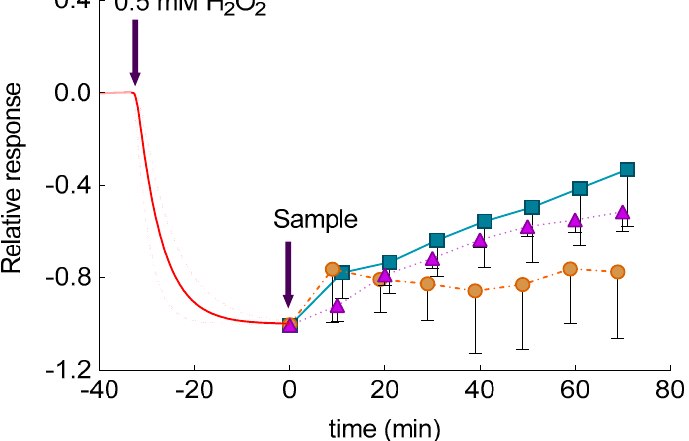
Figure 7. Relative, average amperometric current response of skin covered oxygen electrode immersed in CBS, pH 5.5, to addition of H 2 O 2 (0.5 mM, red dotted and solid lines, n = 13) CA sol (CA 0.5 mM, triangle, n = 3); CA-ETHO (CA 0.5 mM, square, n = 6) and unloaded ETHO (circles, n = 4).